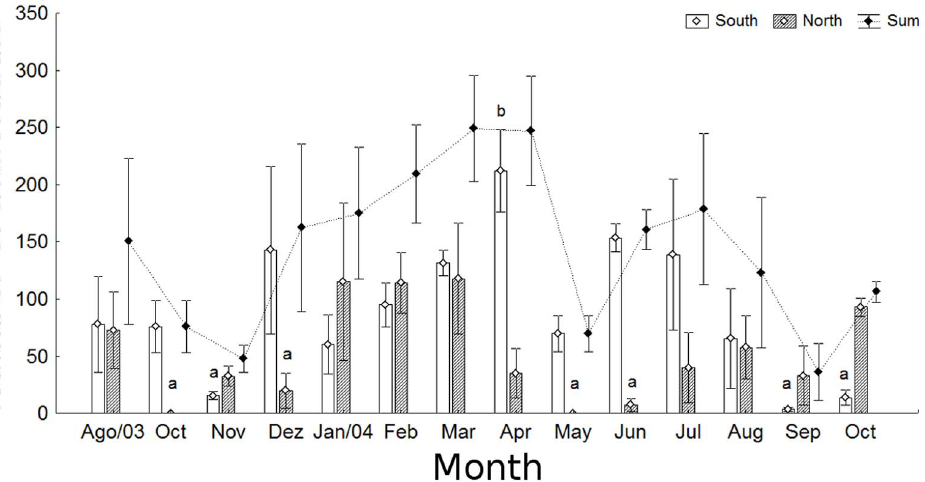
Figure 1. Spatial and temporal variation in number of individuals. Spatial and temporal variation in the number of individuals (mean 6 standard error; a =0.05) of Cathorops spixii in Caraguatatuba Bight. The fish were sampled from August 2003 through October 2004. Different letters denote significant differences among months and areas, discriminated by the SNK test; absence of letters indicates no difference from any other value.